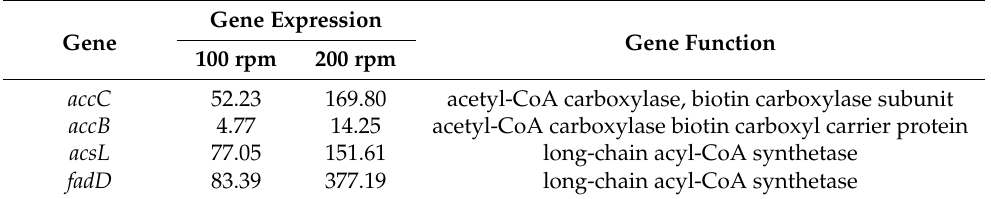
Table 2. Gene expression of fatty acid biosynthesis in Bacillus velezensis CMT-6 at different dissolved oxygen concentrations.